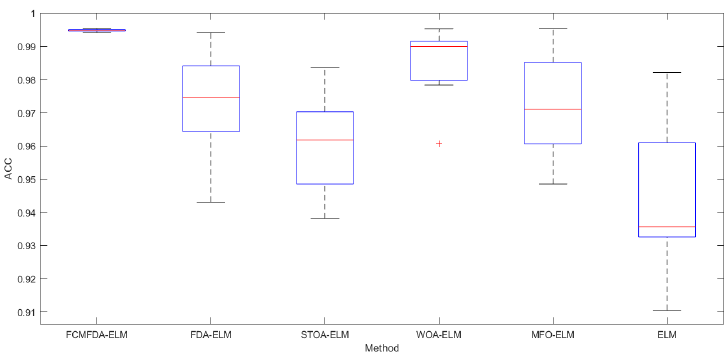
Figure 12. Box graph of each classification algorithm (Fish4Knowledge).